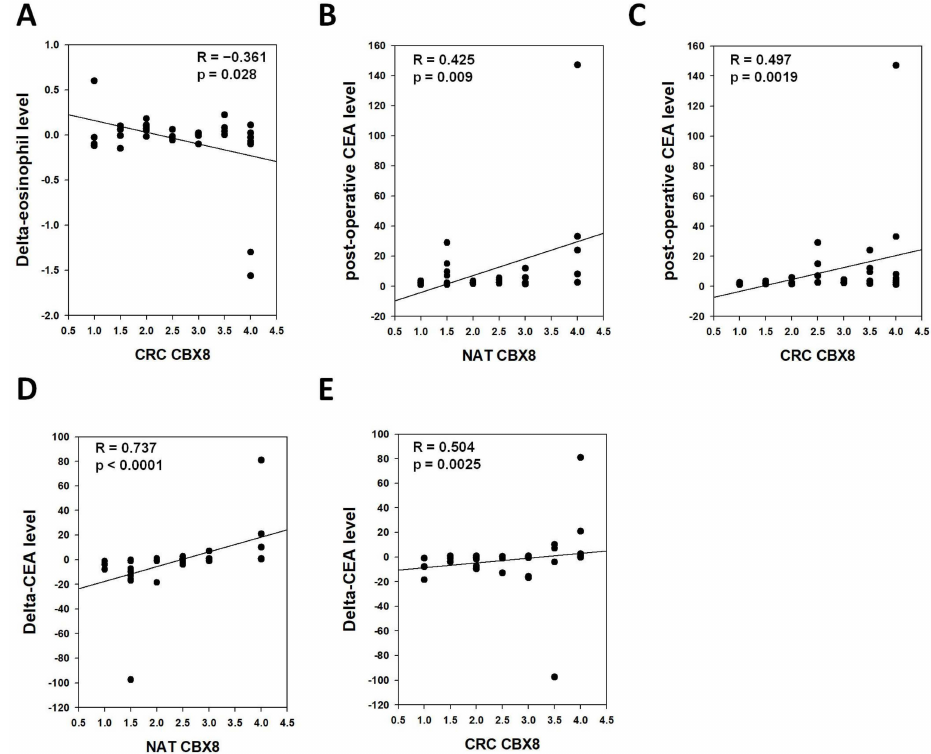
Figure 4. Correlation between NAT or CRC CBX8 protein level and blood immune cell profiles in CRC patients. ( A ) The CRC CBX8 level was inversely correlated with dyanmic changes (post-operative minus pre-operative) in eosinophil level. ( B , C ) CBX8 protein levels in ( B ) NAT and ( C ) CRC were positively correlated with post-operative CEA level. ( D , E ) CBX8 protein levels in ( D ) NAT and ( E ) CRC were positively correlated with dynamic changes (post-operative minus pre-operative) in CEA